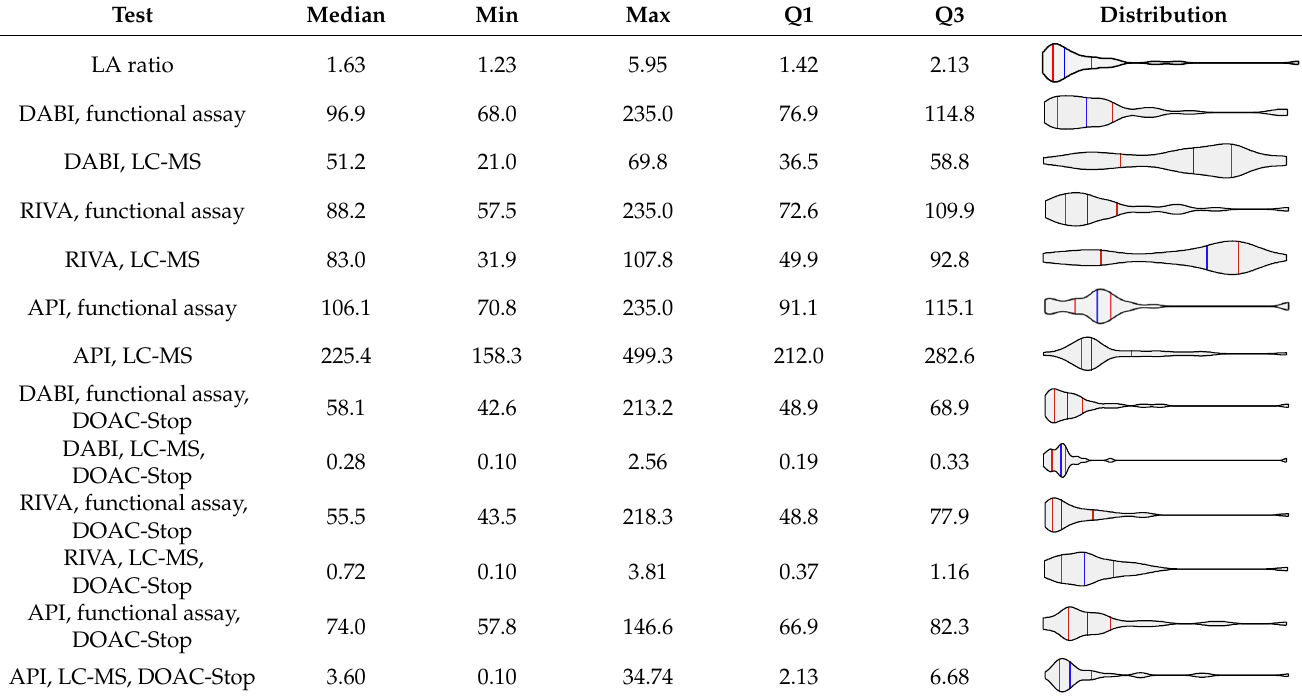
Table 1. Descriptive statistics and visualization of the data distribution of lupus anticoagulant (LA) ratio levels and concentrations of direct oral anticoagulant (DOAC) levels evaluated by the functional assays or by LC-MS method before and after DOAC-Stop procedure. All values are expressed in units ng/mL. Abbreviations: DABI, dabigatran; RIVA, rivaroxaban; API, apixaban.